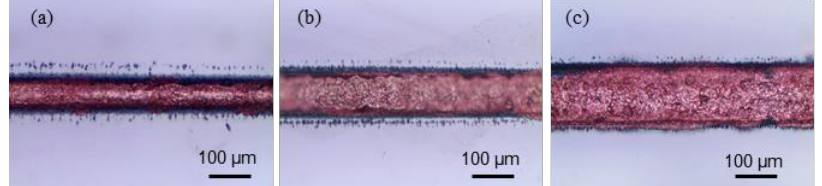
Figure 8. Optical images of embedded copper wires from the top view. Widths of ( a ) 50 µm, ( b ) 100 µm, and ( c ) 150 µm.